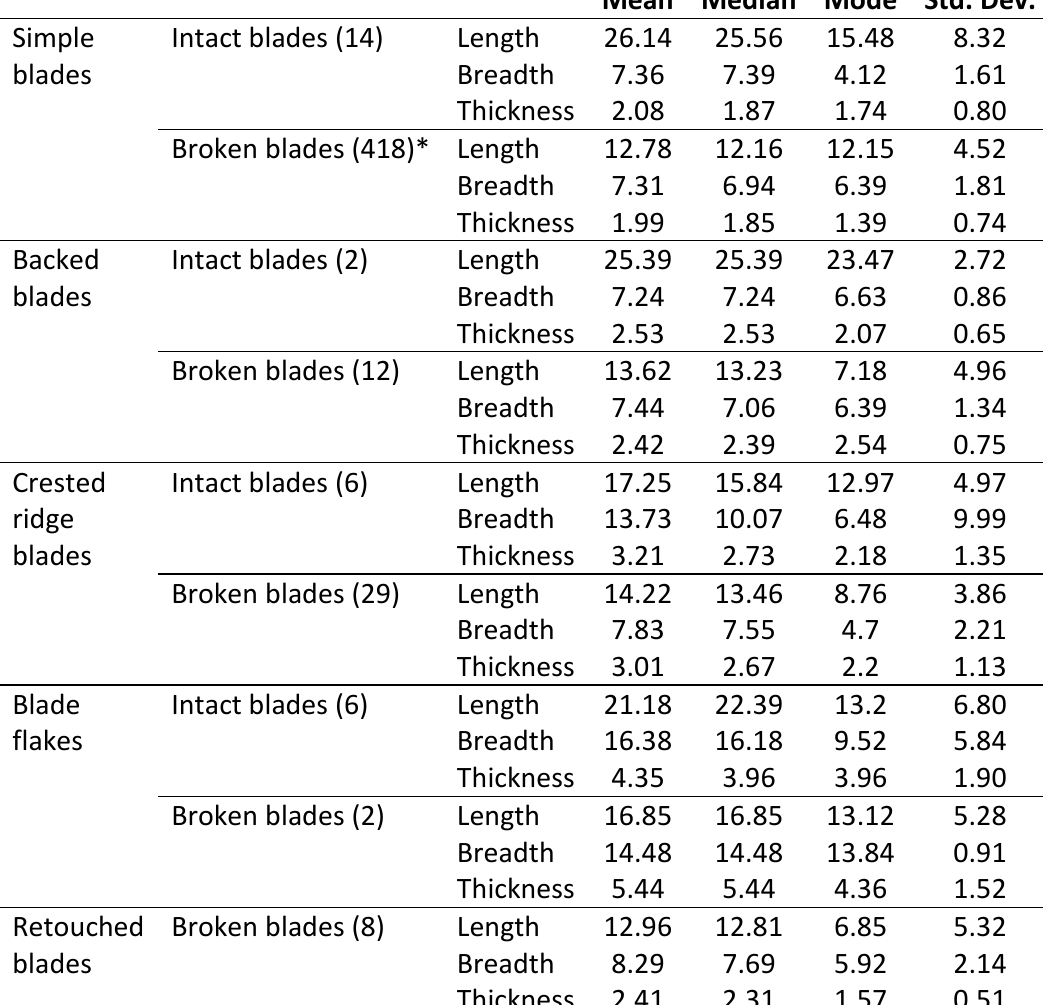
Table 2: Metric analysis of various blades (size in mm)